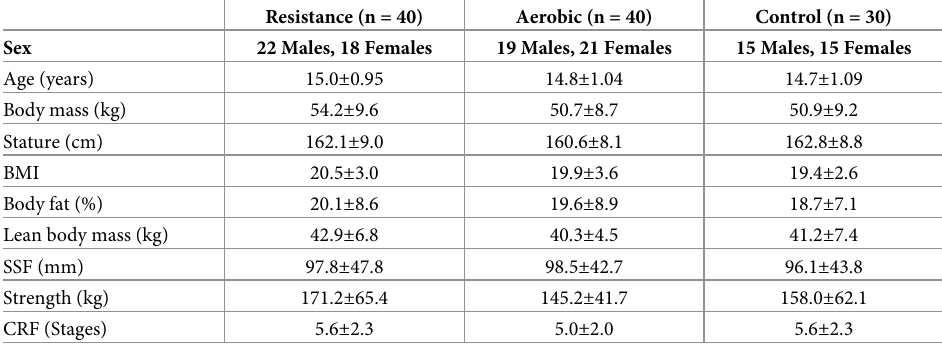
Table 2. Pre-test characteristics of n = 110 participants with complete data at post-test.